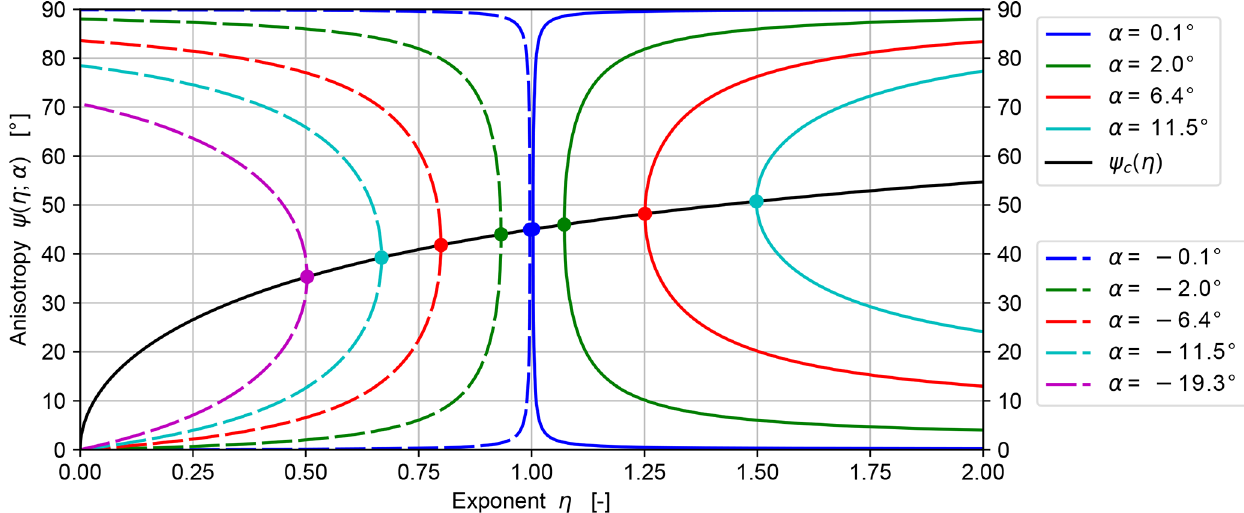
Figure 9. Ray anisotropy ψ ( η ; α ) (coloured curves) as a function of gradient exponent η and its value ψ c (black line and solid circles) at the